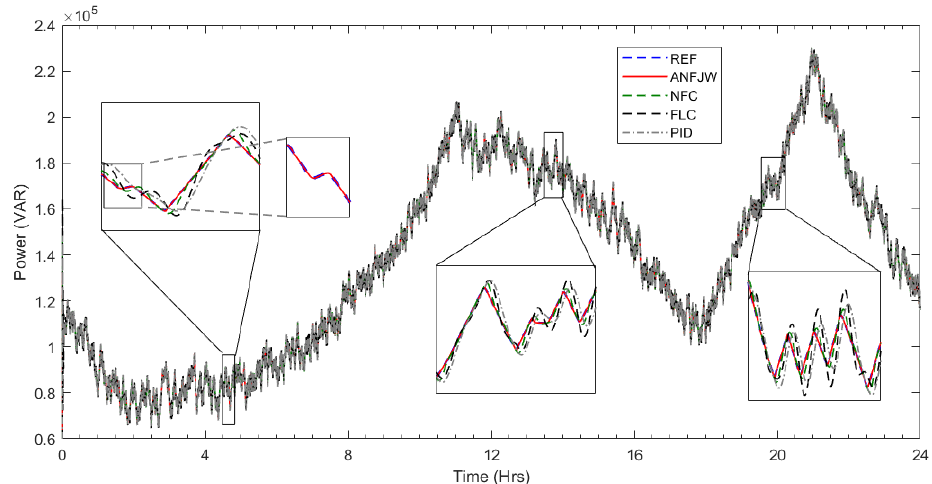
Figure 13. Output real power comparison at different intervals.